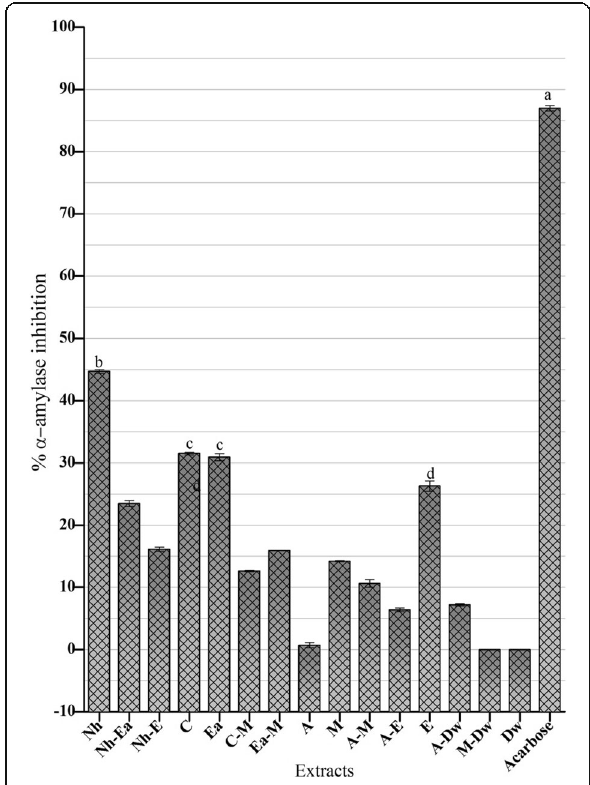
Fig. 5 α - amylase inhibition assay of A. bracteosa extracts. Acarbose is used as a standard with an IC 50 33.73 μ g/ml. Values are presented as mean ± Standard deviation ( n = 3). The columns with different superscript ( a-d ) letters show significantly (P < 0.05) different